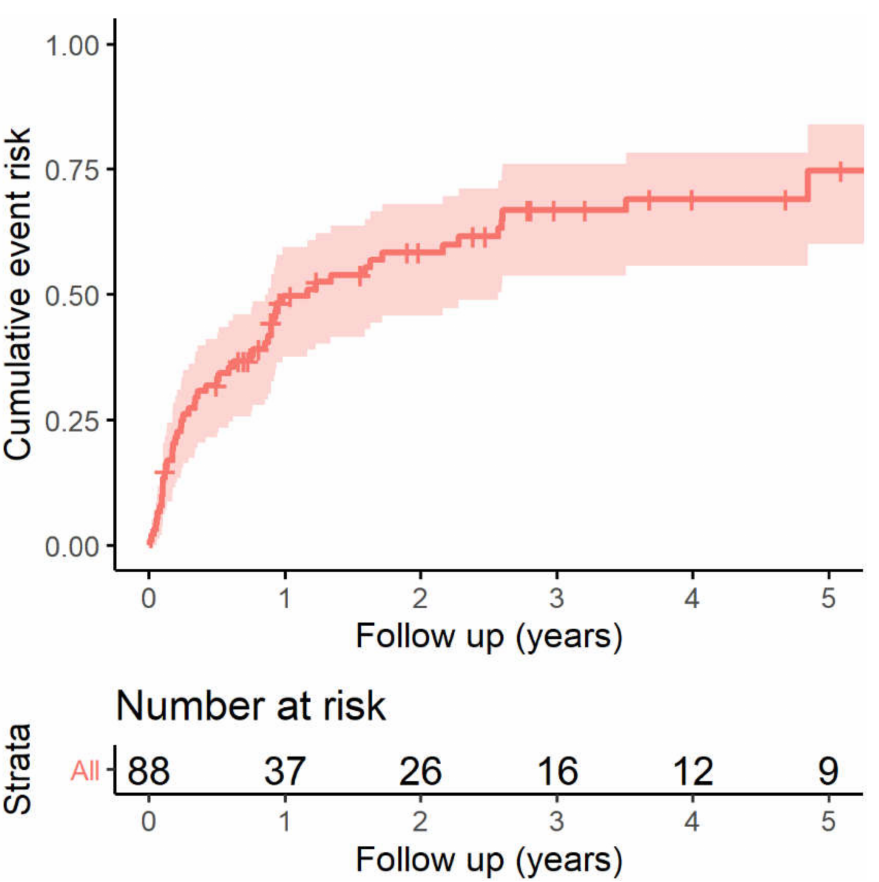
Figure 1. Kaplan–Meier analysis of the appropriate ICD therapy for total population. ICD, im- plantable